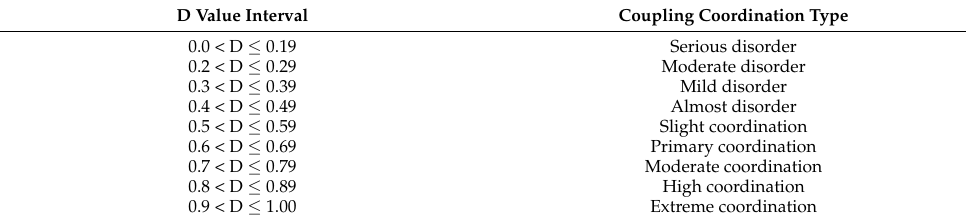
Table 4. Classification of coupling coordination